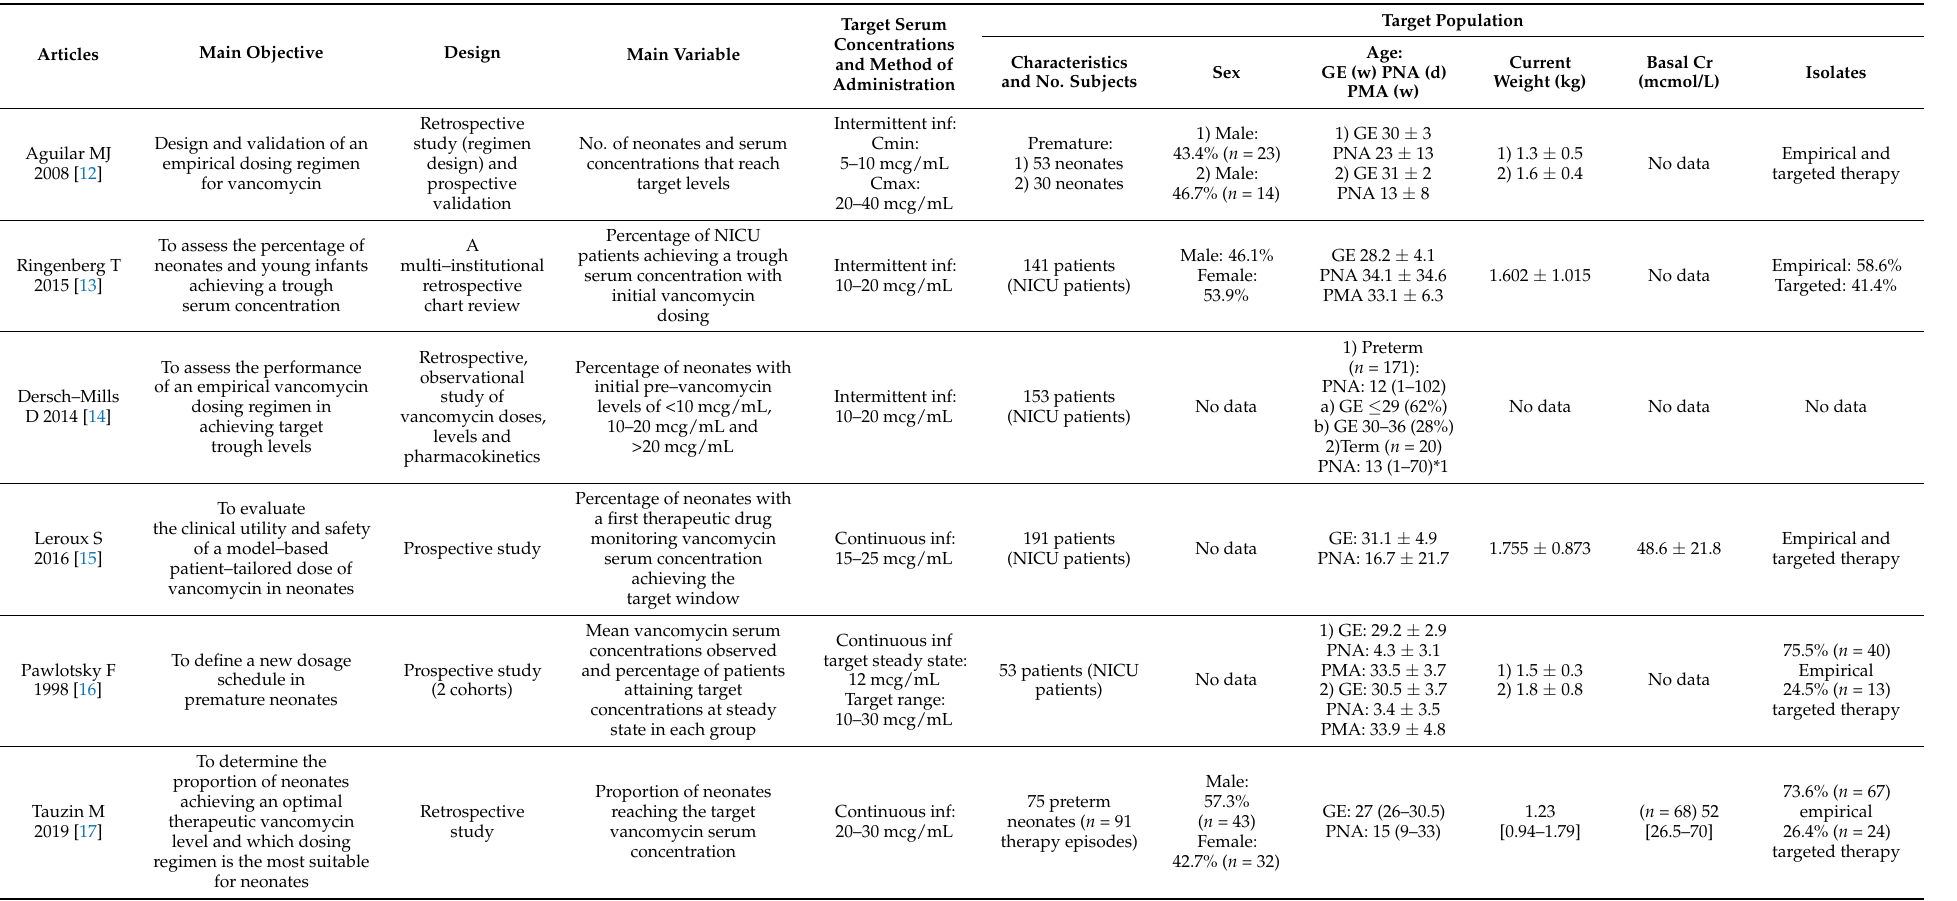
Table 2. Design and target population of each of the identified